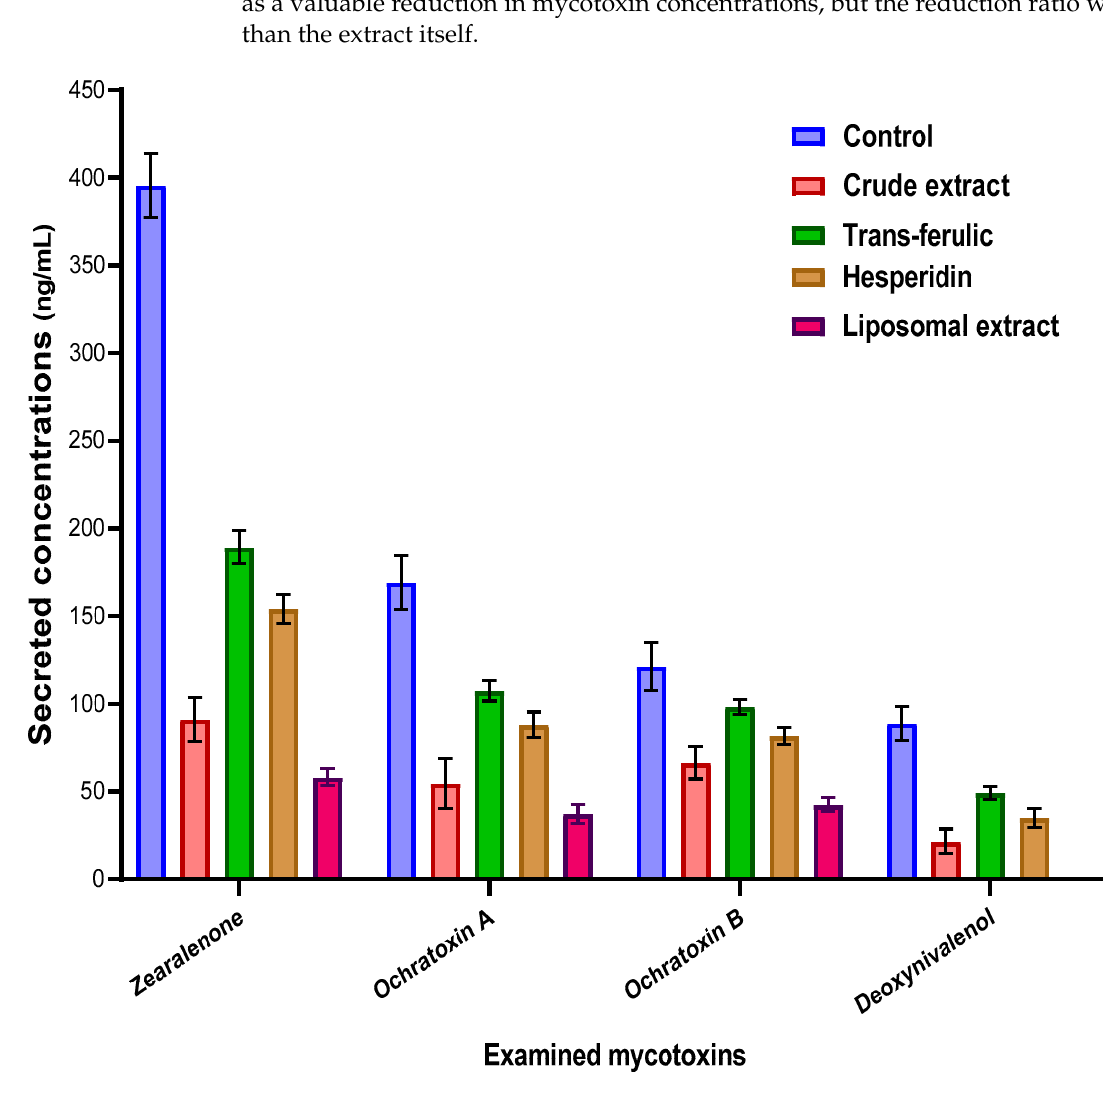
Figure 4. Anti-mycotoxigenic effect of the crude and liposomal extracts of the byproducts compared to two standards of the phenolic compounds.